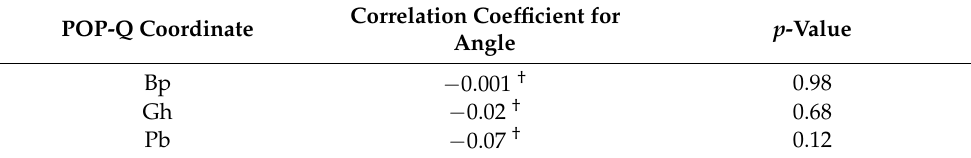
Table 3. Cont. Correlation Coefficient for p -Value POP-Q Coordinate Angle Bp − 0.001 † 0.98 Gh − 0.02 † 0.68 Pb − 0.07 †